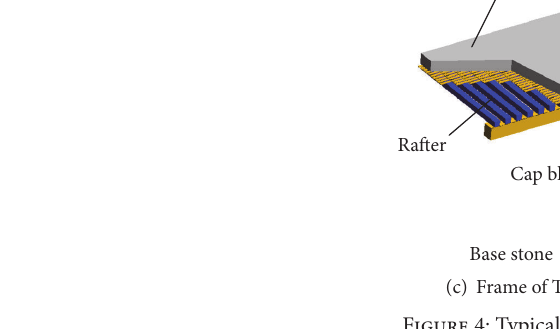
Figure 4: Typical Tibetan timber structure.